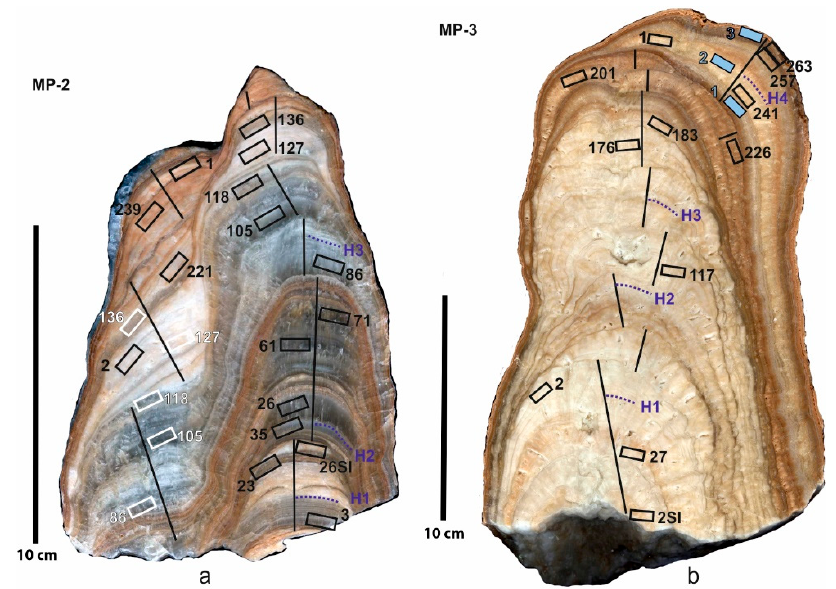
Figure 2. Longitudinal sections of the stalagmites MP-2 and MP-3. Open black squares mark the sample positions for U-Th dating (real depth), open white squares on MP-2 denote the depth positions transposed onto parallel stable isotope tracks and the full light-blue squares mark the 14 C-dated samples. Solid lines indicate the growth axes along which the samples for the stable isotopes were taken, and the dotted lines mark the series of samples for the Hendy tests. Note the narrowing of the successive growth layers in the porous white sections and the draping compact darker layers, discussed later in Section 4.4.1.